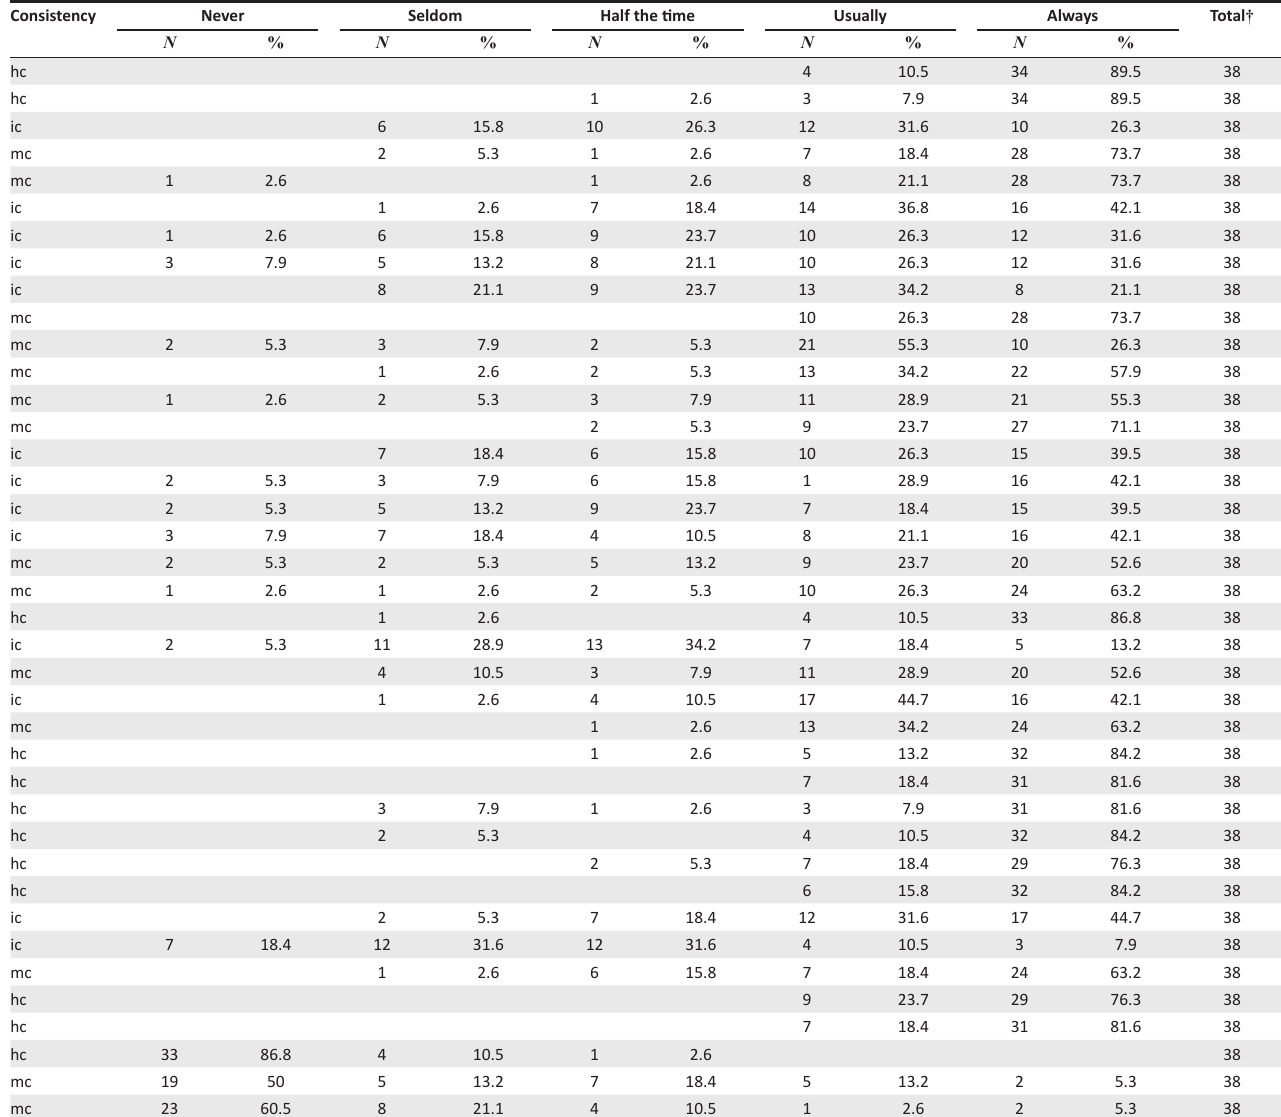
TABLE 2: Frequency and consistency of clinical components and resources utilised in the clinical swallow assessment by participants.